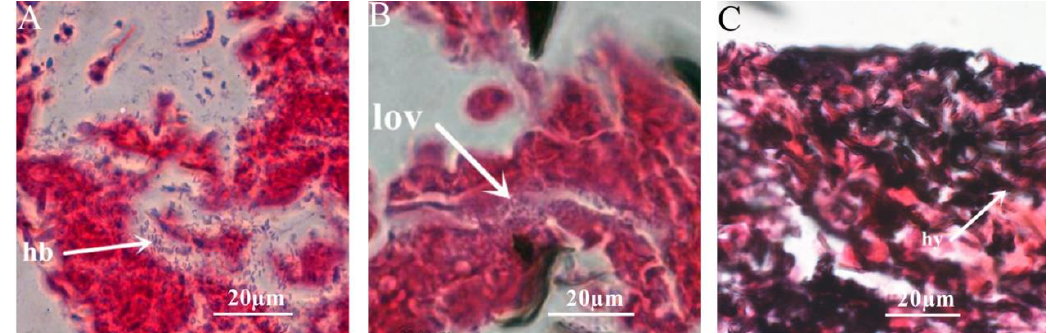
Figure 7. Representative histopathological images of sagittal sections of F. occidentalis infected with B. bassiana , (96 h p.i.). ( A ) Extensive hyphal bodies proliferation in the insect body, ( B ) hyphal bodies in the lateral oviducts (lov), and ( C ) insect cadavers covered with hyphae.